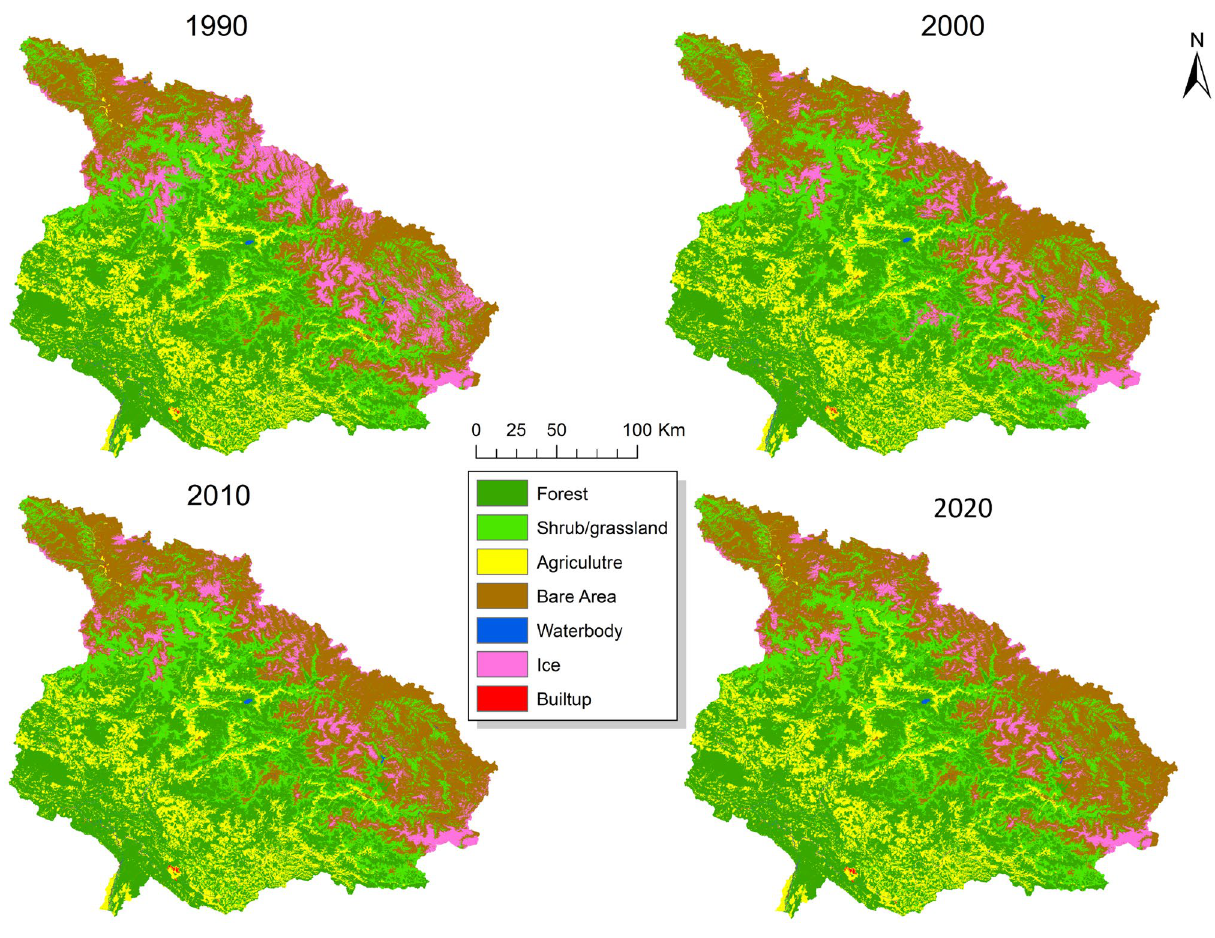
Fig. 2 Land Cover Maps of KRB